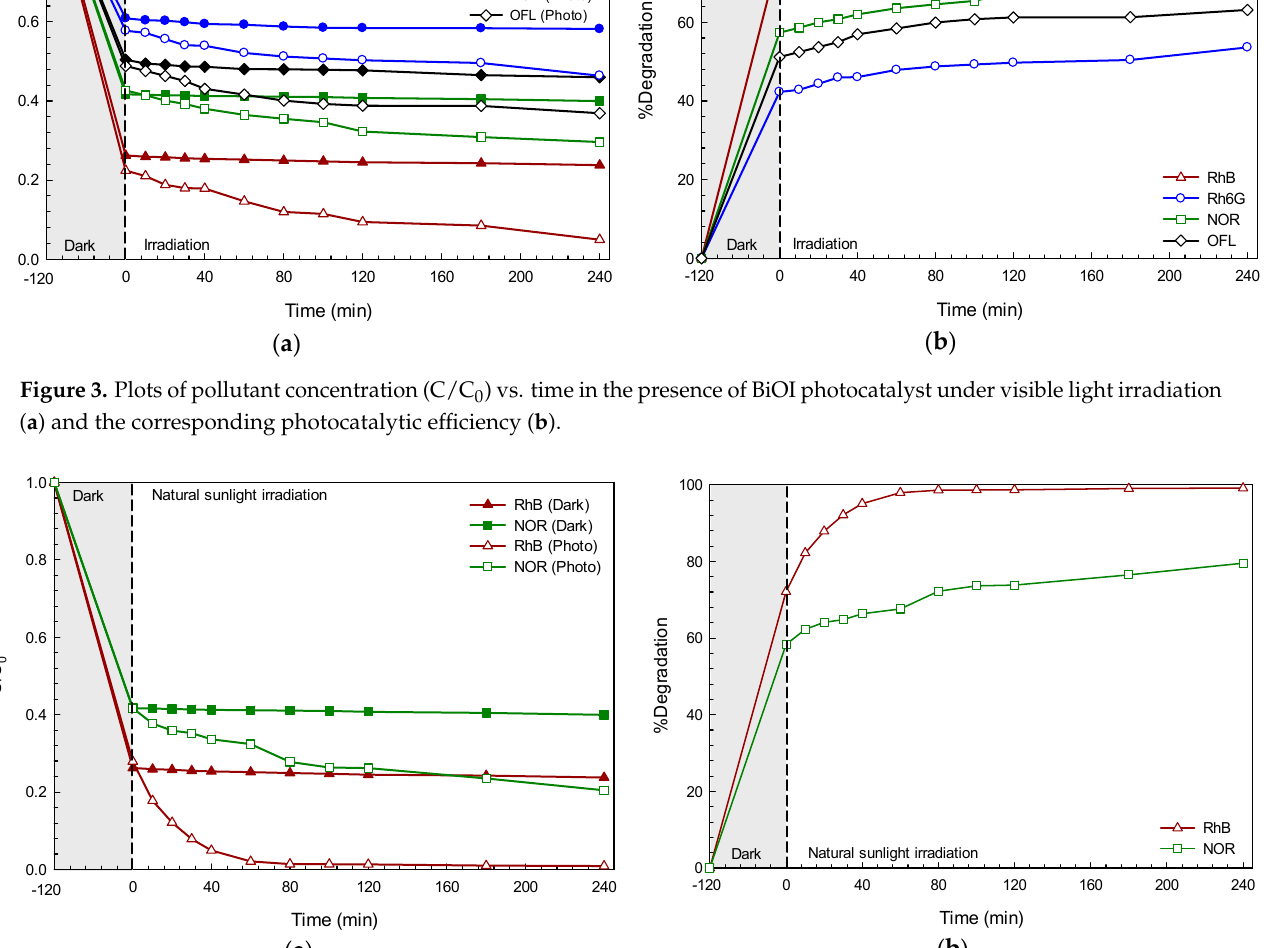
( b ) Figure 5. Total organic carbon (TOC) in RhB dye solution as a function of time ( a ) and the corresponding photocatalytic activity ( b ).